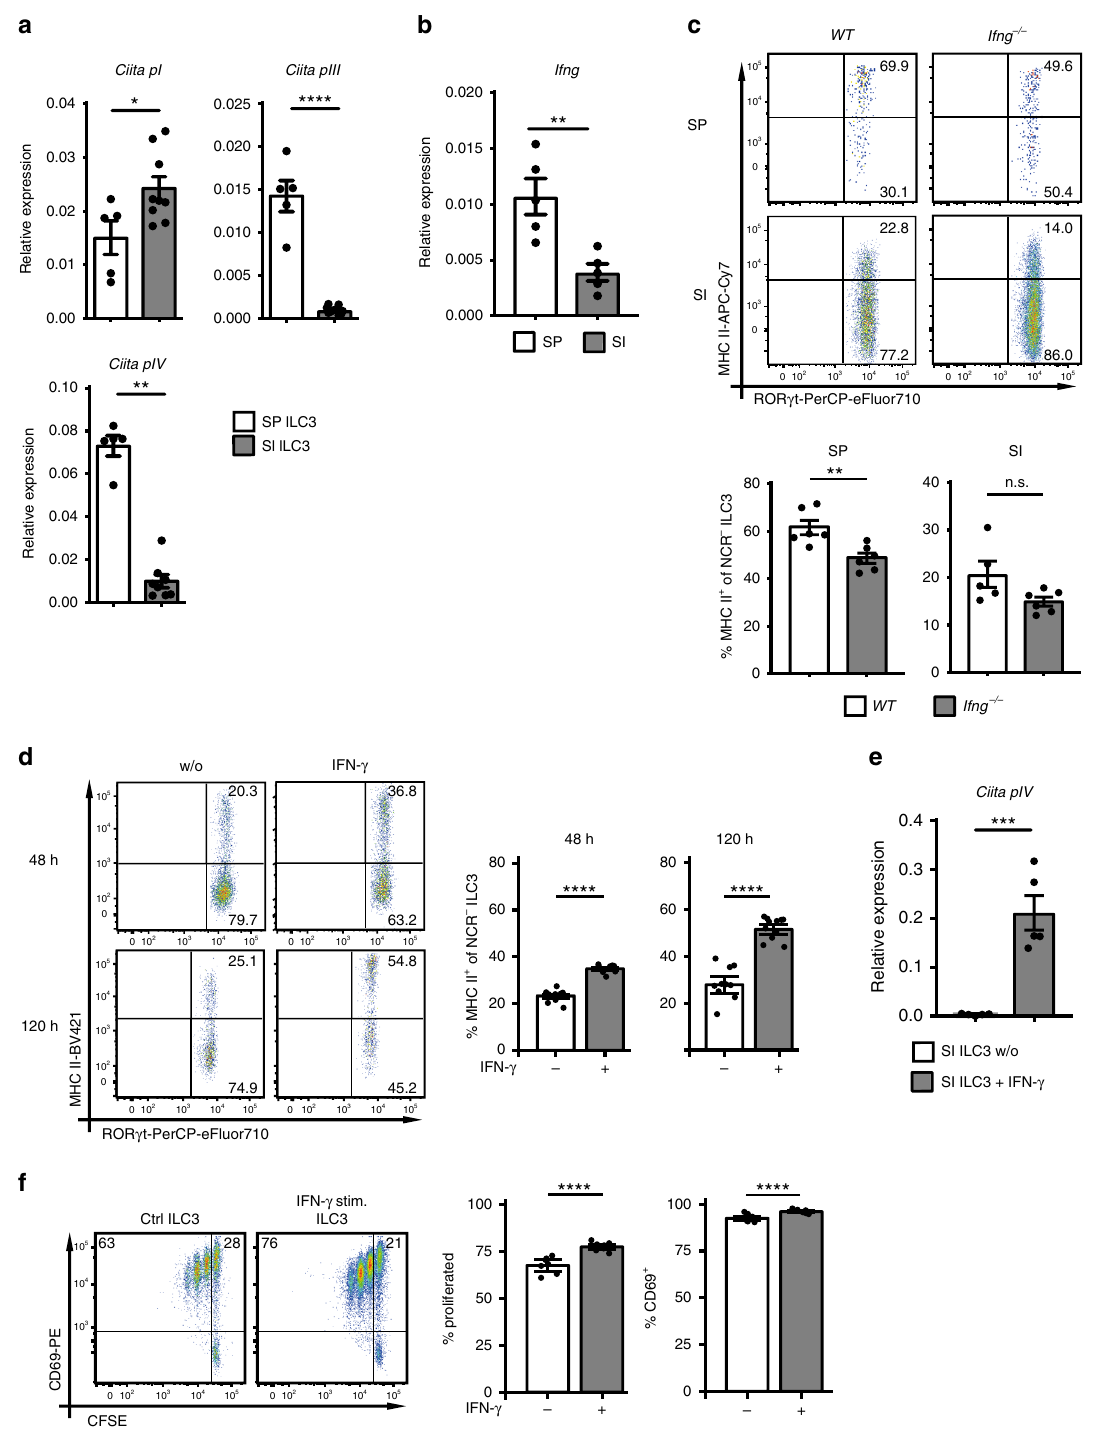
critical factors regulating ILC3-T-cell responses and disease